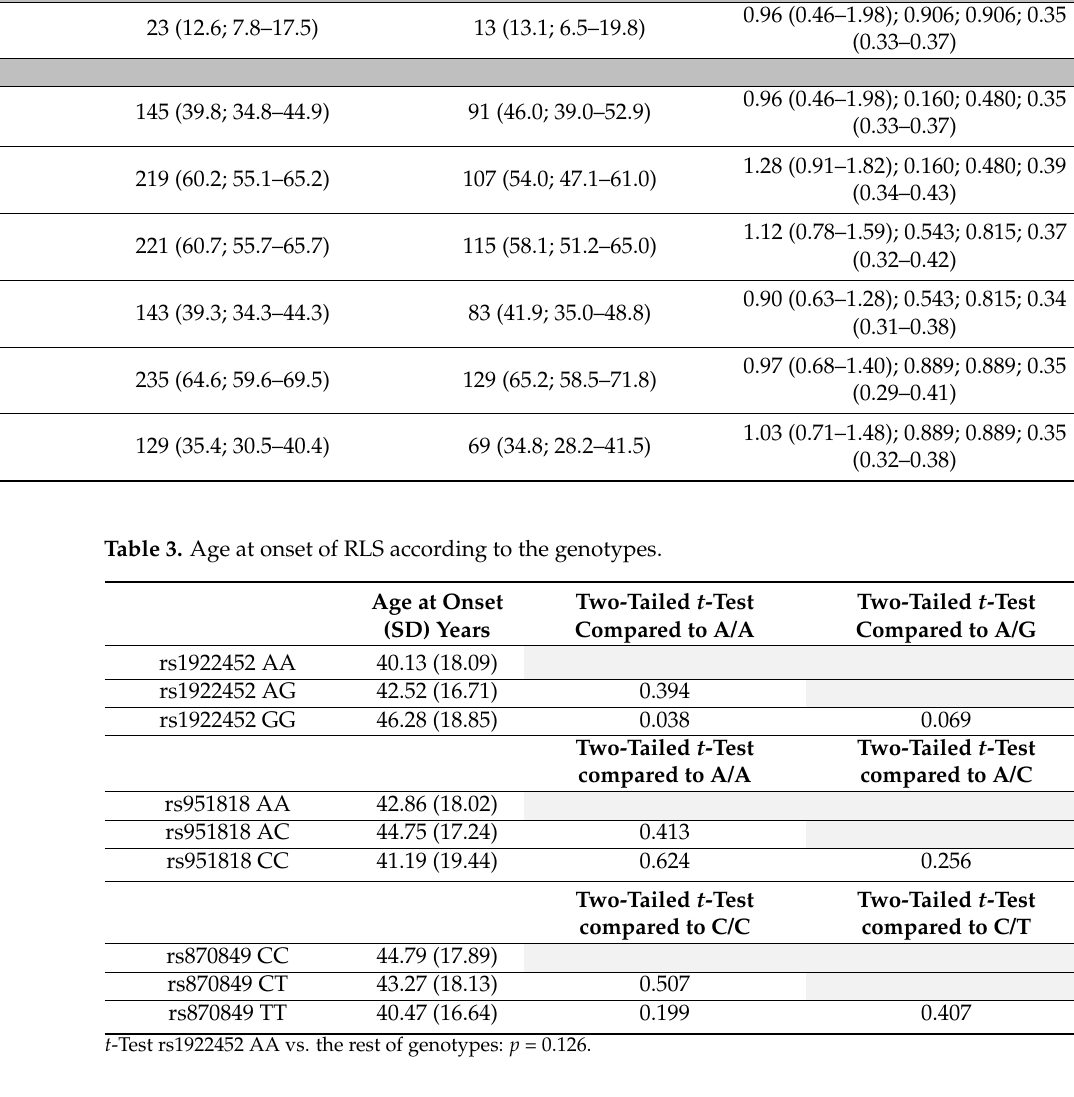
Table 4. Severity of RLS (IRLSSG) according to the